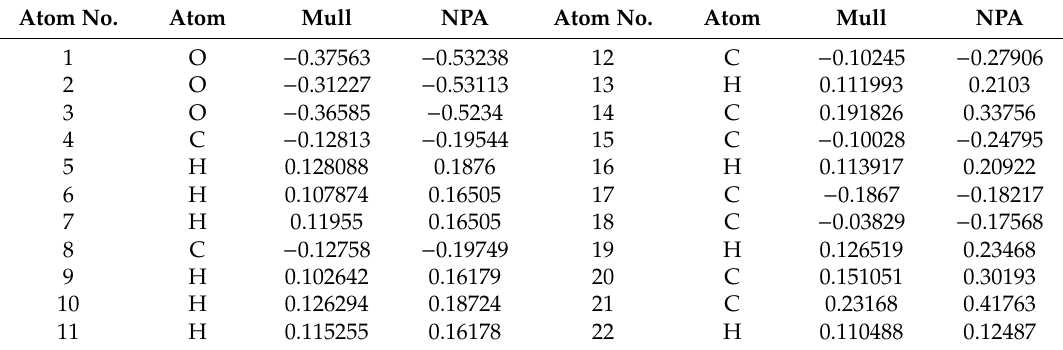
Table 3. Mulliken (Mull) and natural population analysis (NPA) atomic charges.